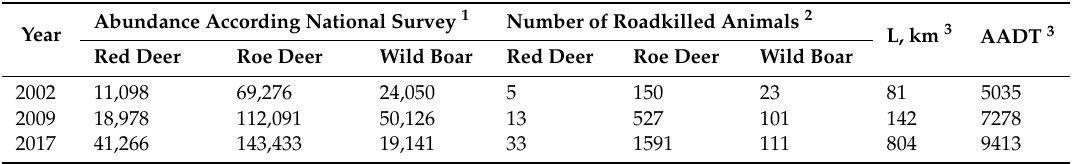
Table 6. Changes in numbers and roadkills of ungulates, annual average daily tra ffi c intensity on the main roads (AADT) and length of wildlife fences (L) in Lithuania in